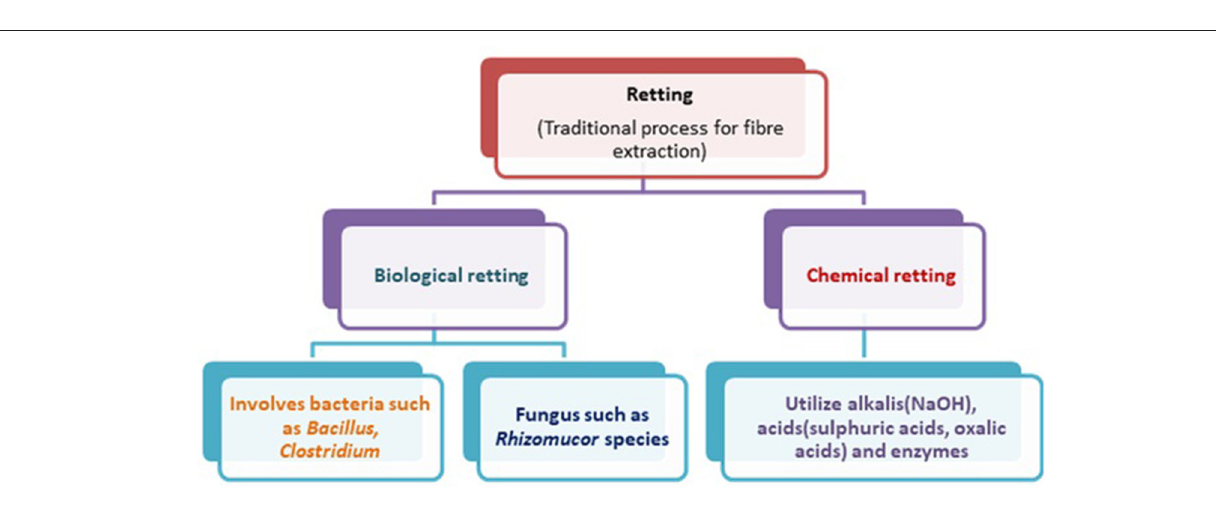
FIGURE 3 | Schematic representation of retting